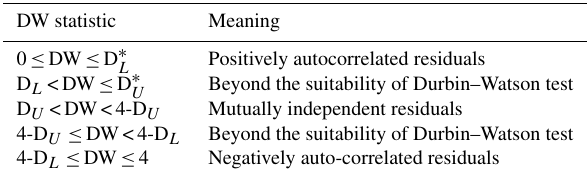
Table 1. Range of Durbin–Watson statistic and the related